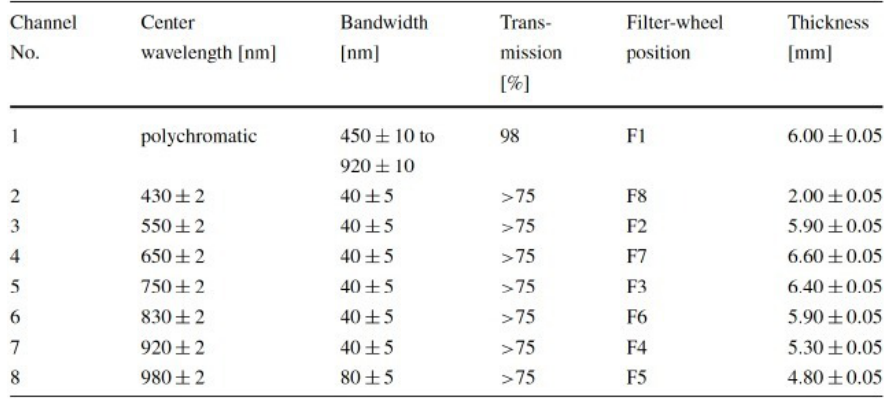
Figure 15. Filter settings of Framing Camera 2 of the DAWN mission [24]. For the study presented here, measurements using the clear filter have been utilized